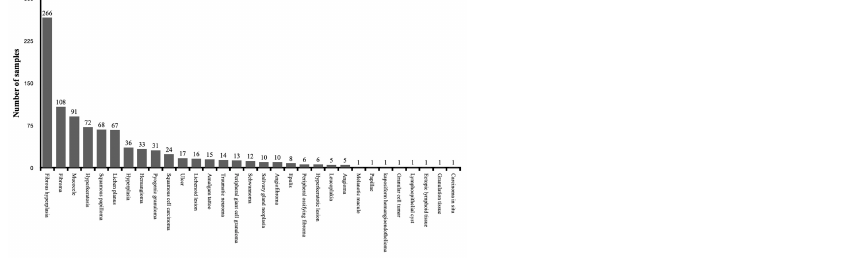
Figure 4. The distribution of the specimens according to the diagnosis of lesions among the clinical studies.